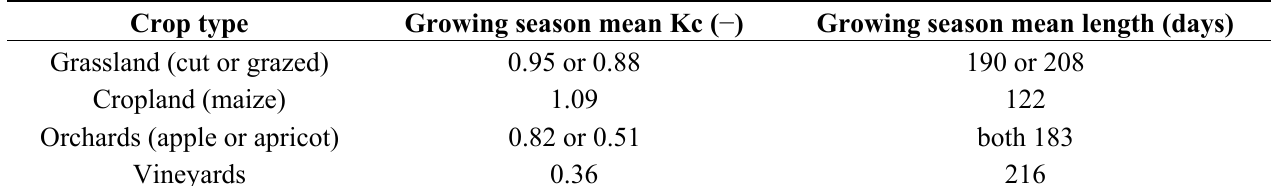
Table 2. Crop specific seasonal mean K for 1981–2009 at the sites specified in Table